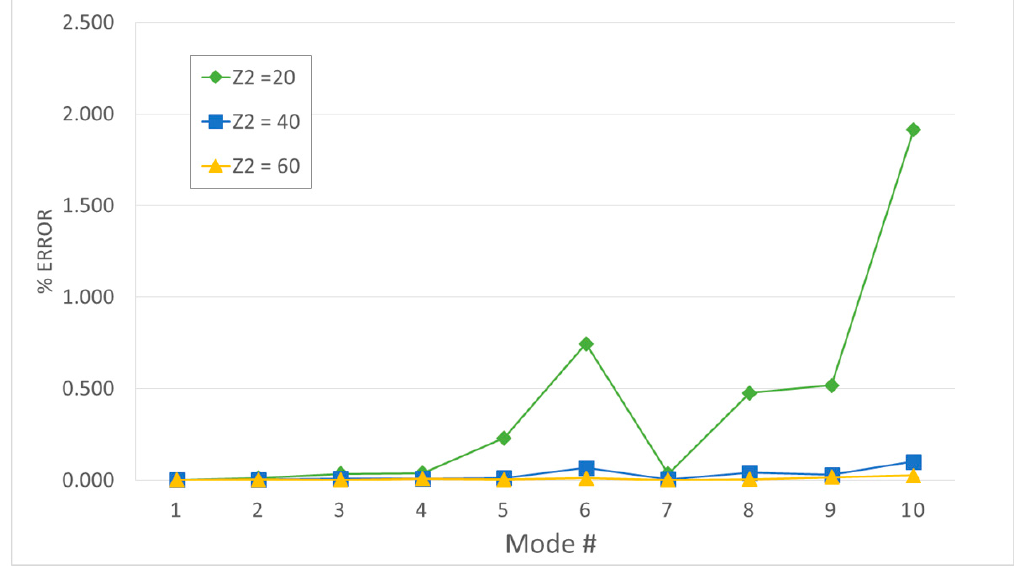
Figure 6. Test Case A (linear elements, Z 1 = 60, h = 13)—accuracy of the two-step method.